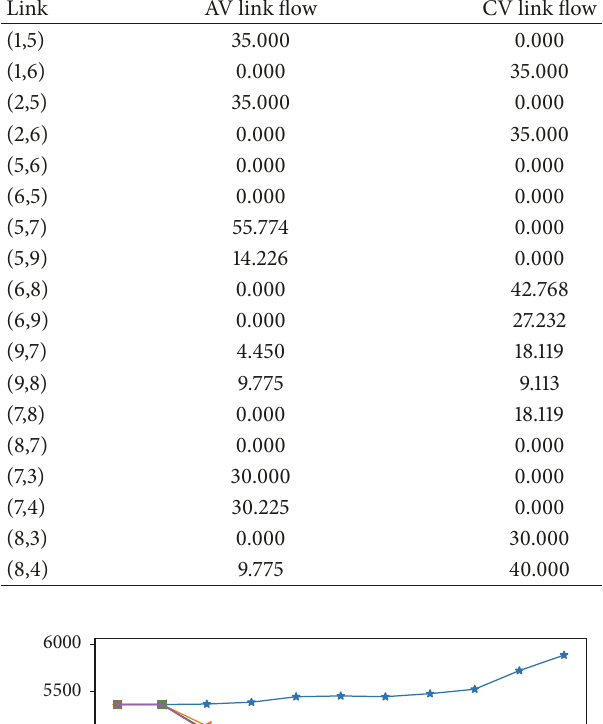
Table 2: Link flows in the network upon implementation of the optimal network design with congestion pricing.